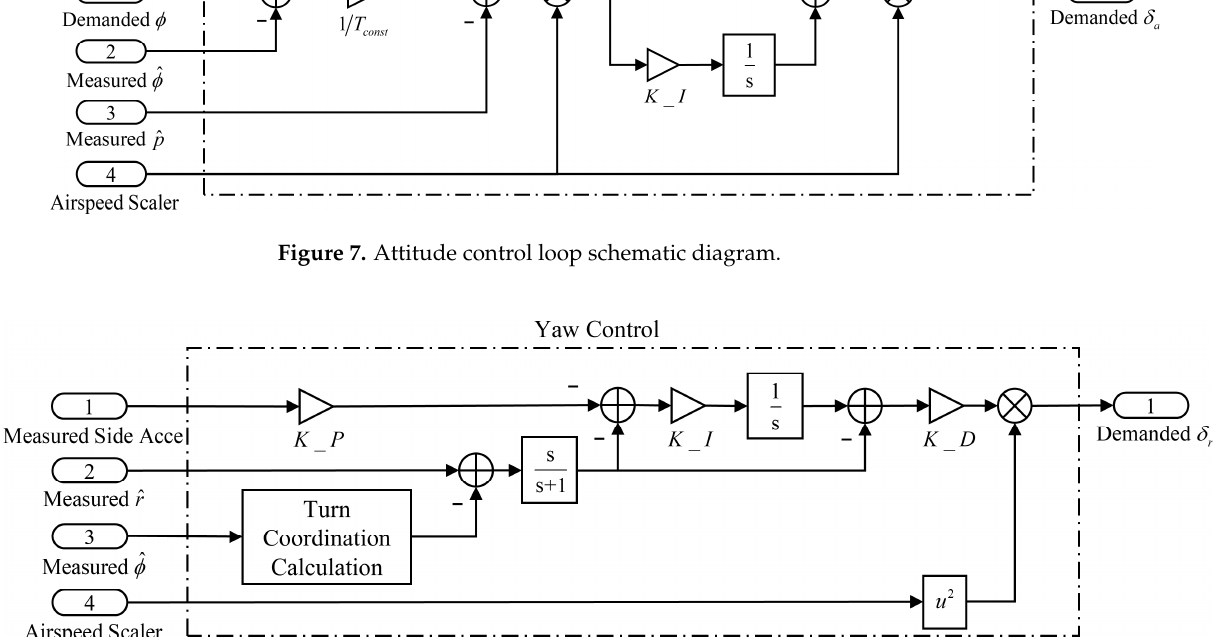
Figure 7. Attitude control loop schematic diagram.